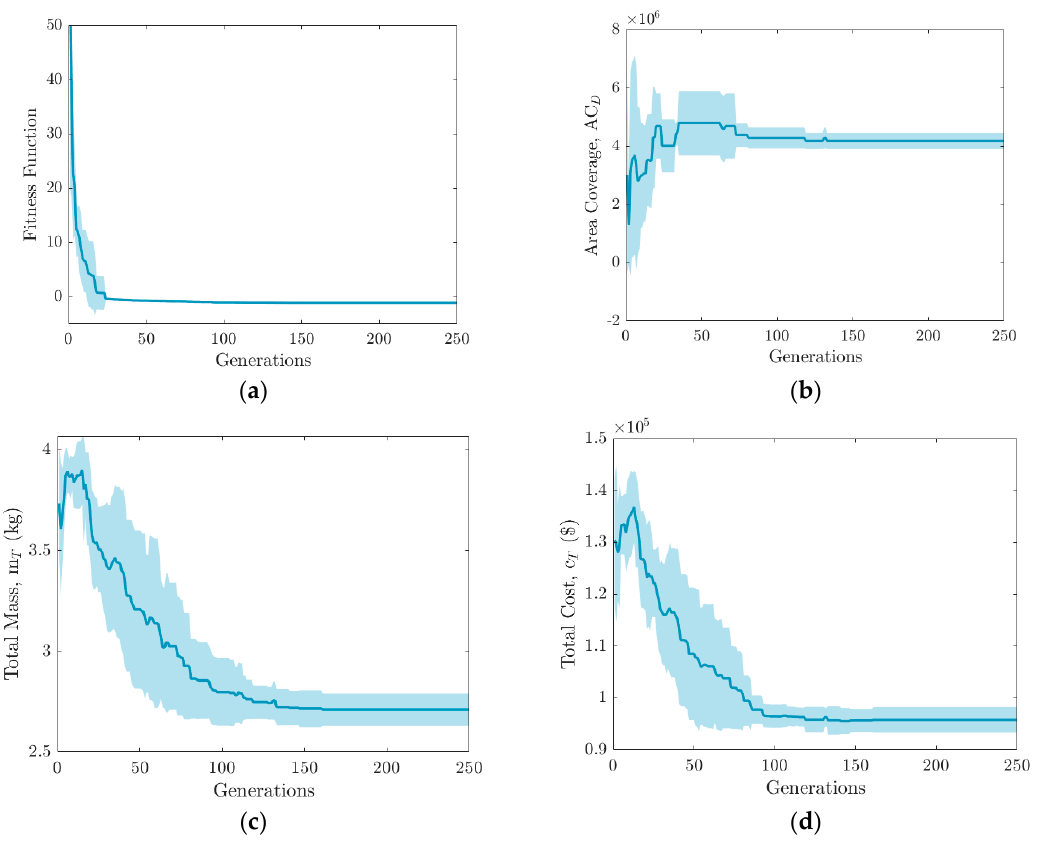
Figure 10. Performance of evolutionary algorithm on the CubeSat design multidimensional multiple-choice knapsack problem (MMKP): evolution of the ( a ) fitness function; ( b ) total downloadable ground area coverage; ( c ) total mass of the CubeSat; ( d ) total cost of the CubeSat, over generations along with the 95% confidence interval over 20 runs.